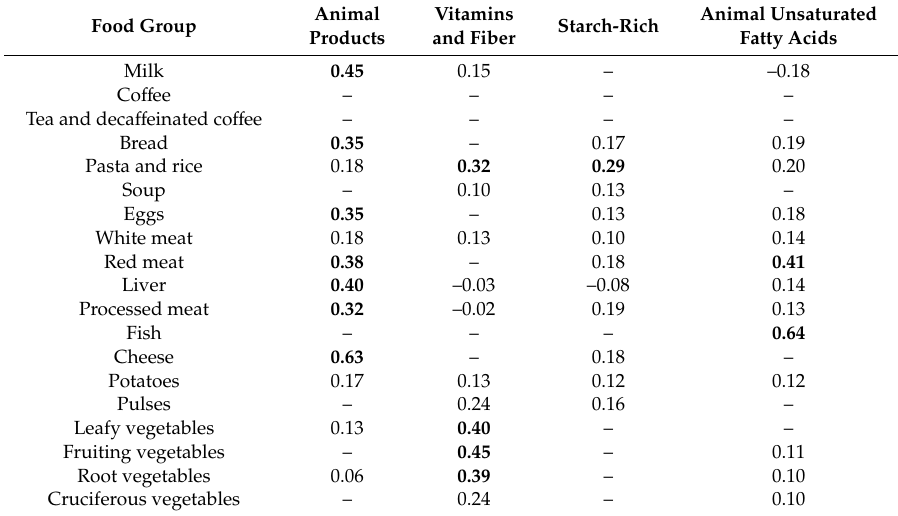
Table 3. Spearman rank correlation coe ffi cients 1 between continuous factor scores derived from principal component factor analysis on nutrient intakes and weekly number of portions for selected food groups and condiments derived on the same